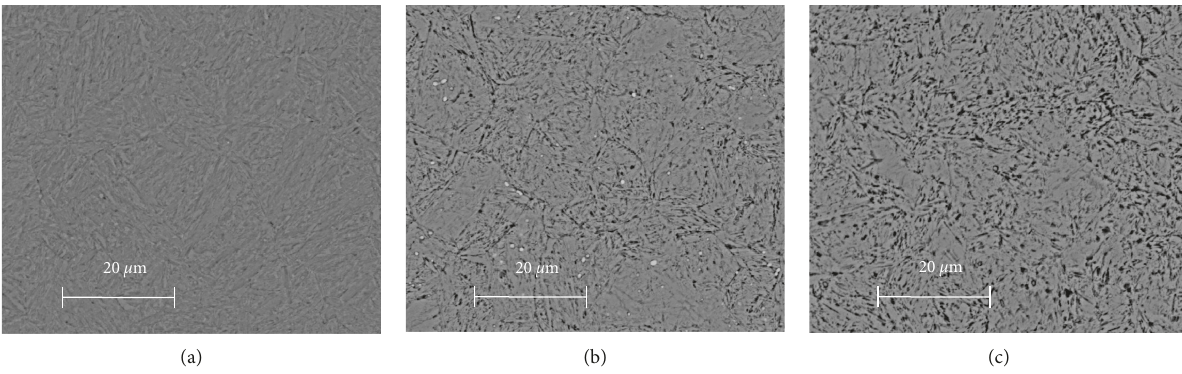
Figure 21: Detailed micrograph of steel 1 (a), steel 2 (b), and steel 3 (c).